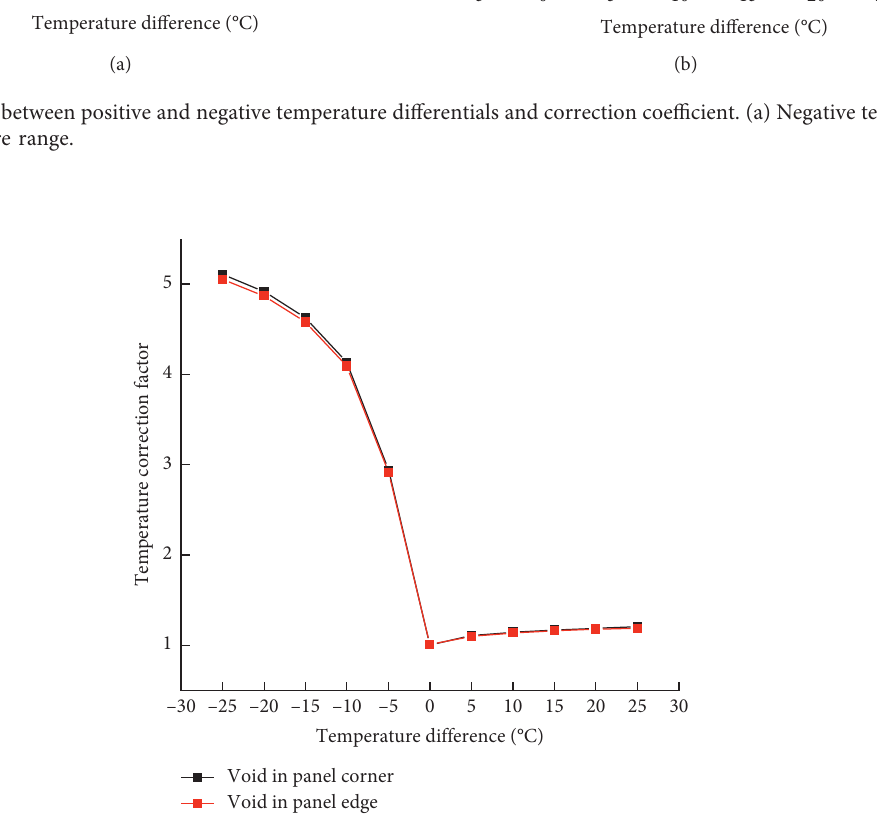
Figure 11: Temperature difference-mean temperature correction coefficient under plate angle void and plate edge void